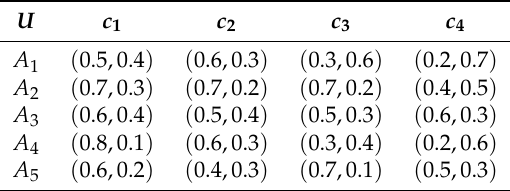
Table 1. Intuitionistic fuzzy soft set I = ( (cid:101) F , C )